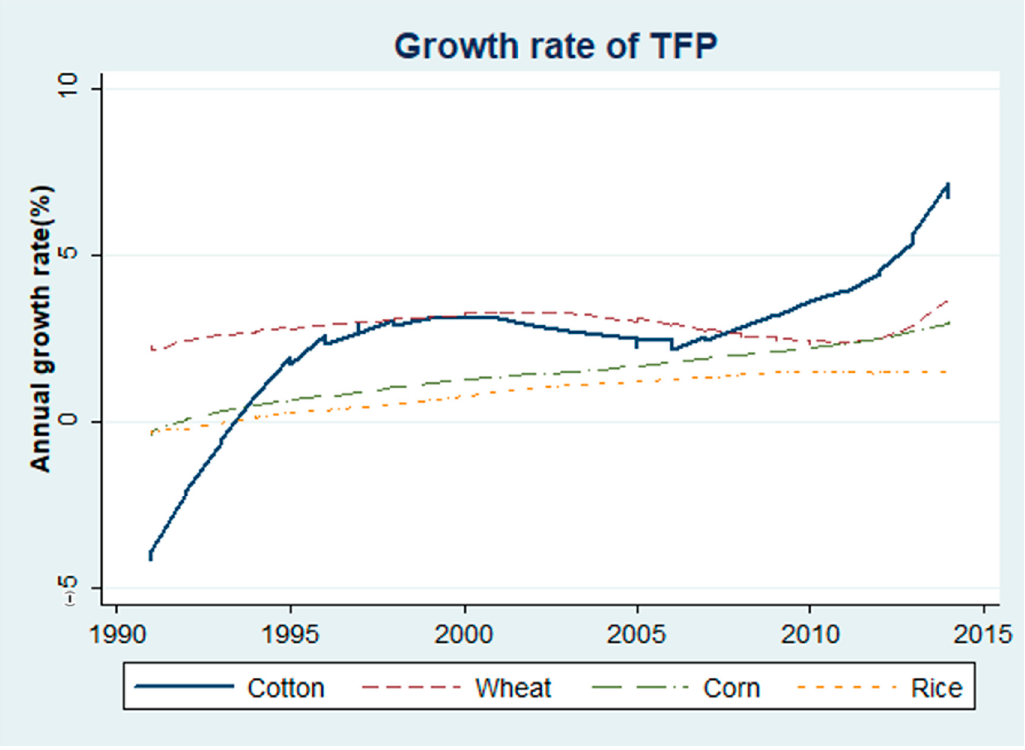
Figure 1. Growth rates of TFP for cotton and grain crops.